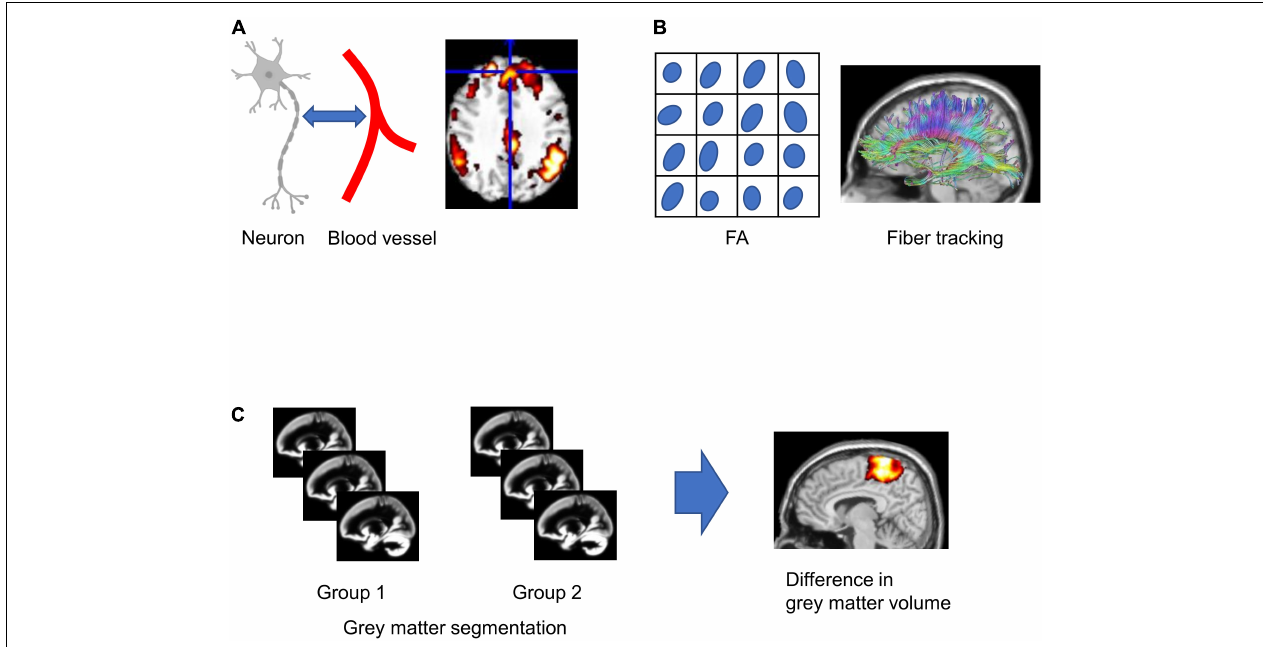
FIGURE 1 | Schematic figures of magnetic resonance imaging (MRI) analysis. (A) Functional MRI relies on the neuron-glia vascular interaction. (B) Fractional anisotropy (FA) is calculated in each voxel, and fiber tracking is calculated from diffusion tensor imaging (DTI). (C) For voxel-based morphometry (VBM), gray matter segmentation in each subject was performed, and the statistical difference in gray matter concentration between groups in each voxel was